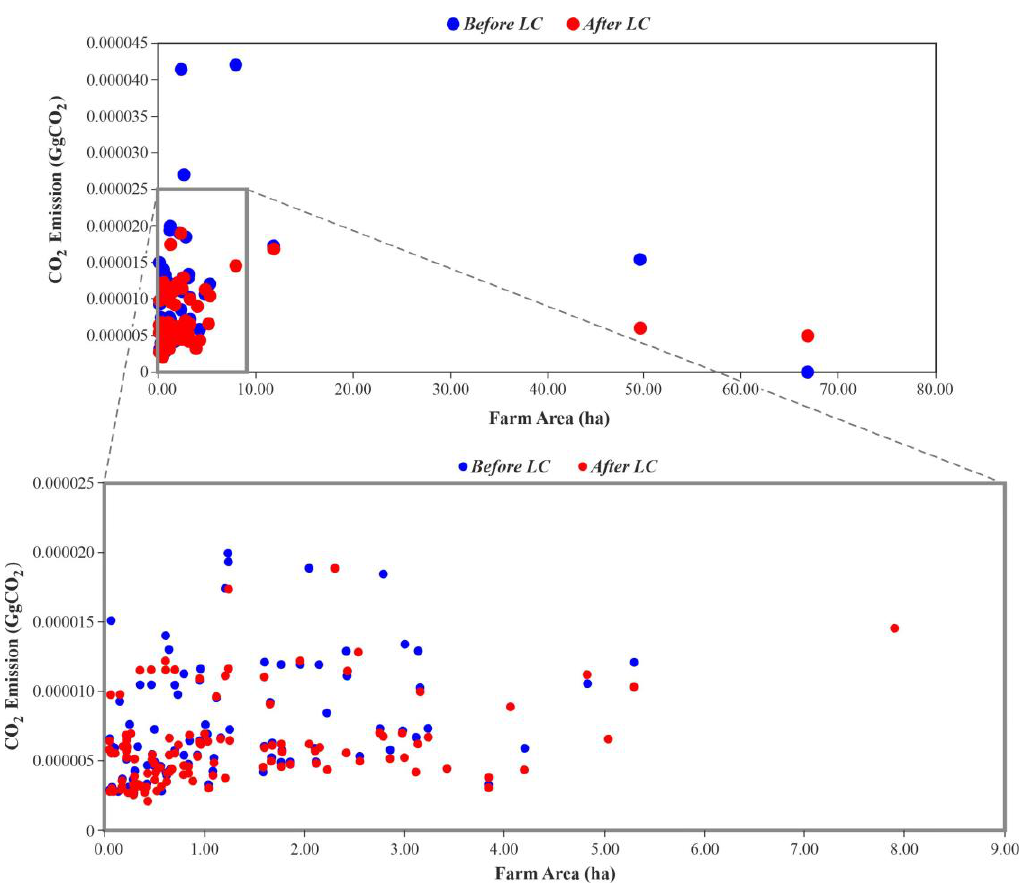
Figure 7. Changes in carbon footprint according to enterprise areas before and after LC (Fatih Neighborhood).